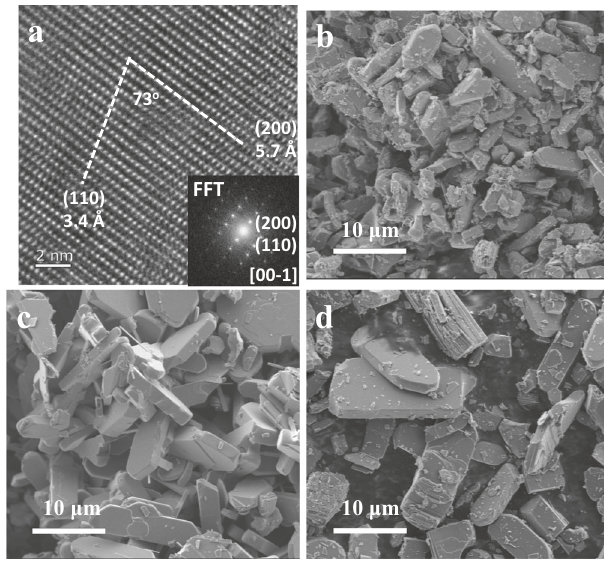
Fig. 5 Morphological characteristics of V 2 O 5 . a HRTEM image of the as- calcined V 2 O 5 sample and the corresponding Fast Fourier transforms (FFTs) image (inset). Representative SEM images of V 2 O 5 sample: b as- calcined, c after 30 pulses of NH 3 reduction at 650 °C and d after CLAO redox cycling at 650